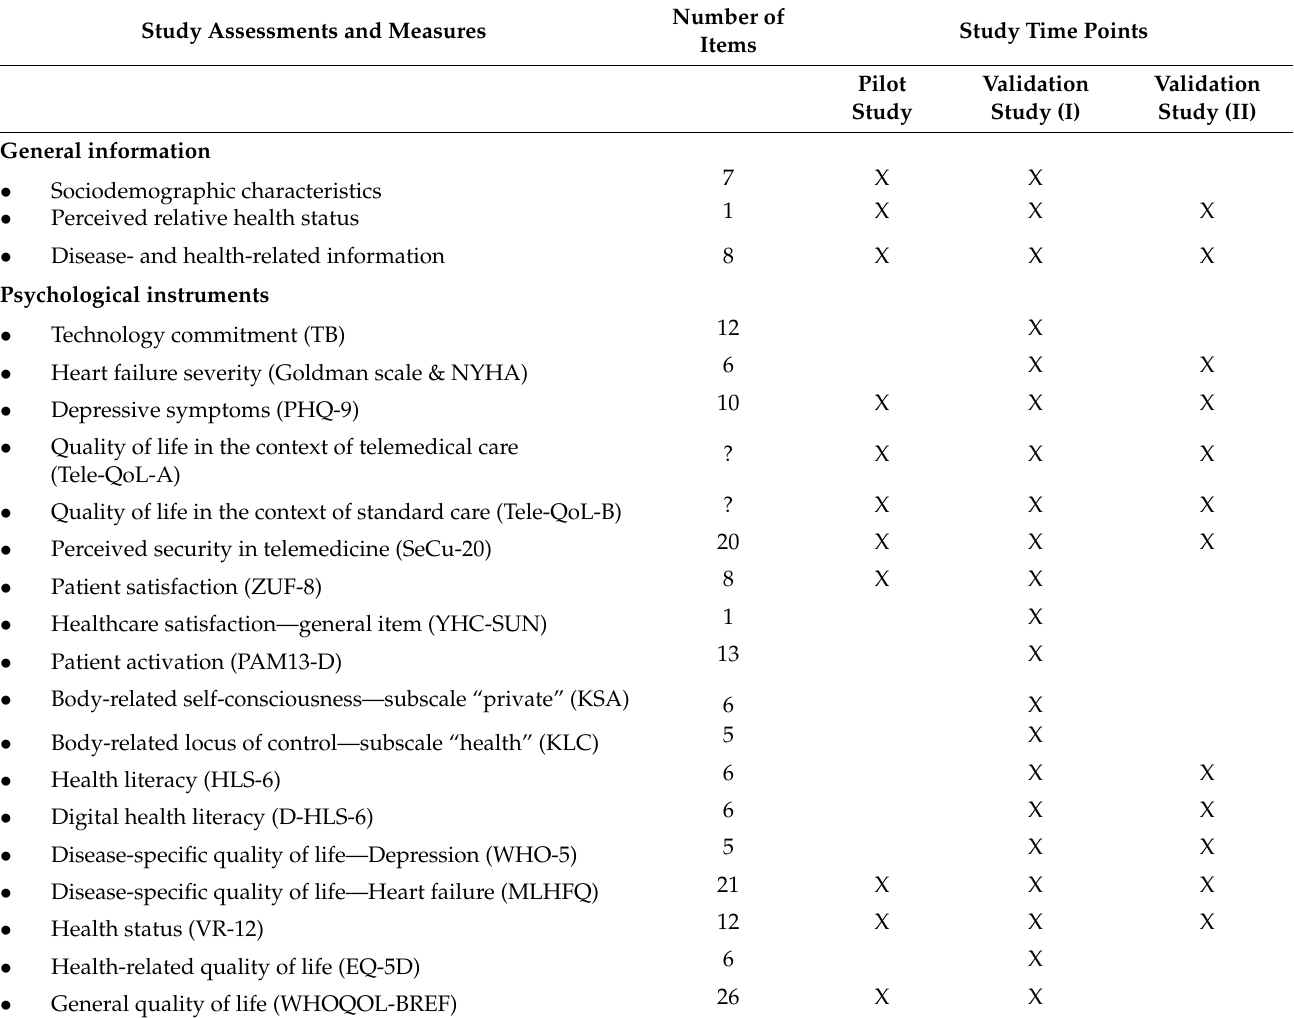
Table 2. Questionnaires and items employed at the different study